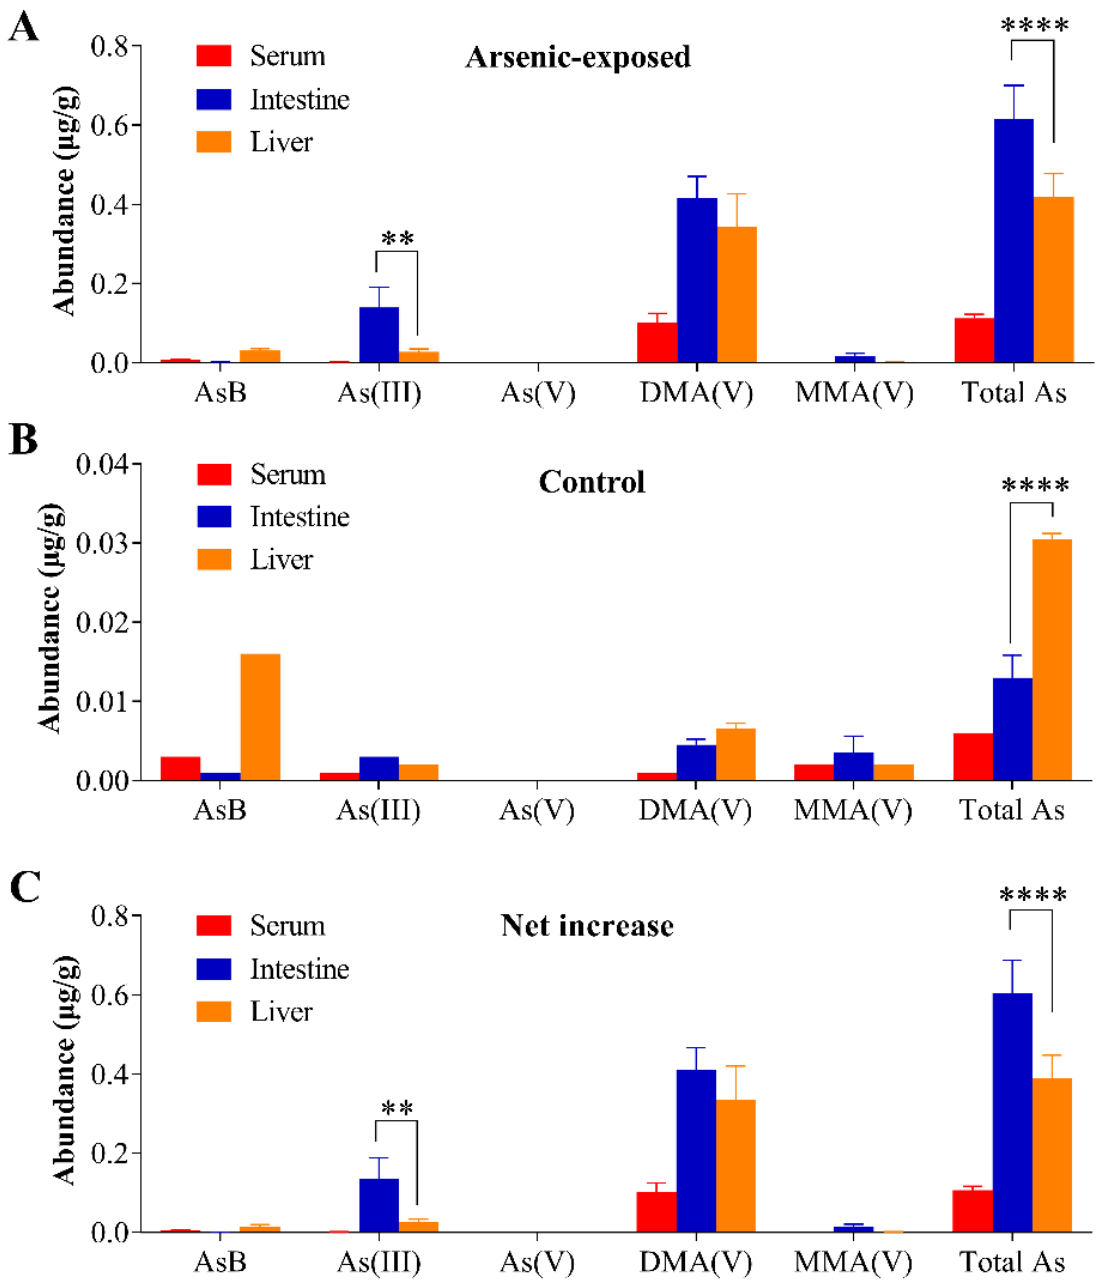
Figure 4. Arsenic levels in tissues from control mice and mice exposed to 25-ppm arsenite orally. Total arsenic and arsenic species levels were determined in the serum, small intestinal epithelial cells, and liver from mice (3–4-month-old female) exposed to 25-ppm arsenite in drinking water for 7 days ( A ), or with drinking water alone ( B ). Net changes in arsenic levels resulting from drinking arsenic water were calculated and shown in panel ( C ) Data represent means ± S.D.; **, p < 0.01; ****, p < 0.0001 (two-way ANOVA followed by Sidak’s multiple comparisons test). Each serum sample was pooled from 2 mice ( n = 1 for control and 2 for exposed); intestinal epithelial cells or liver tissues from individual mice ( n = 2 for control and 4 for exposed) were analyzed. Abbreviations: AsB, arsenobetaine; As(III), arsenite; As(V), arsenate; DMA(V), dimethylarsinic acid; and MMA(V), monomethylarsonic acid.